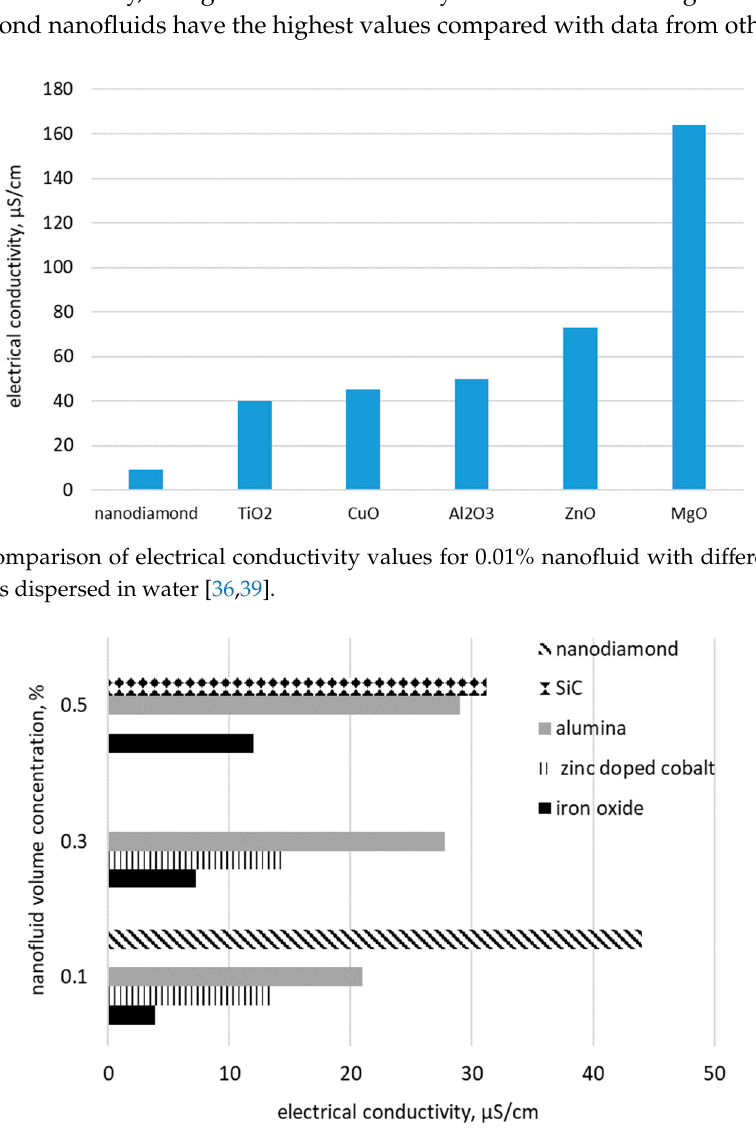
Figure 2 . Electrical conductivity of iron oxide - water nanofluid.